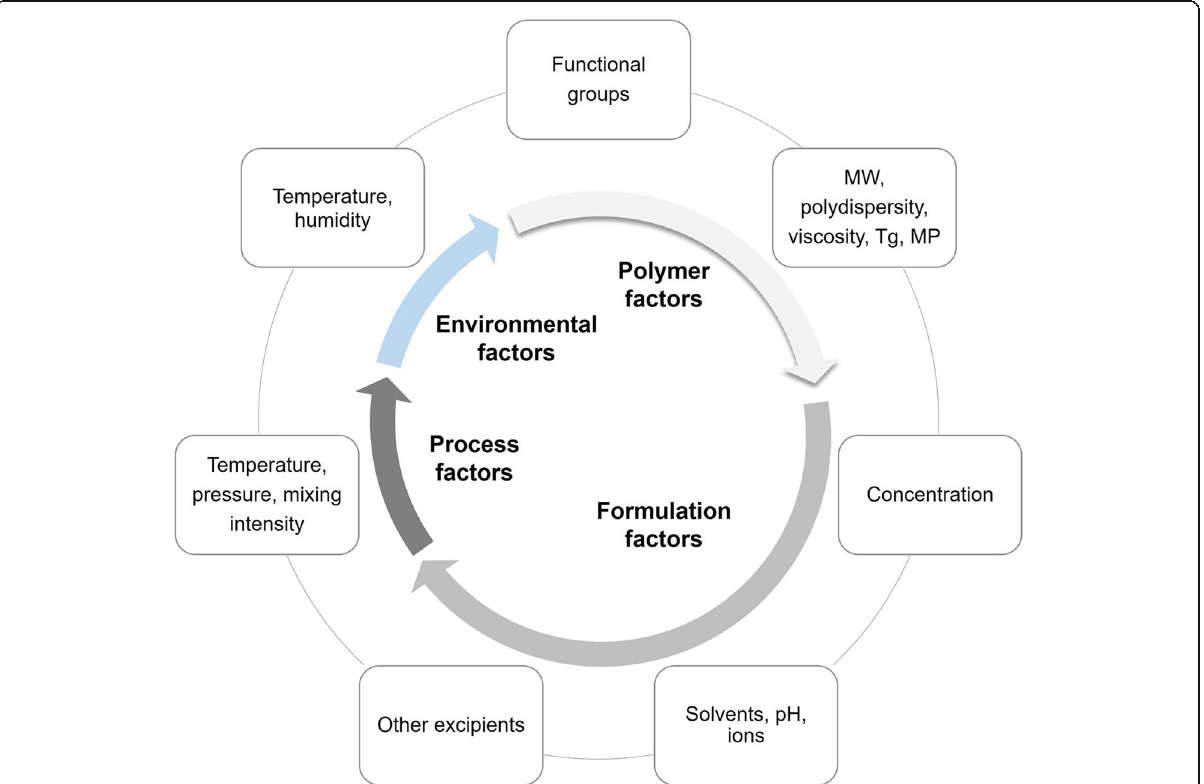
Fig. 2 Factors influencing polymer-polymer interactions. Tg, glass transition temperature (amorphous polymers); MP, melting point (crystalline polymers); MW, molecular